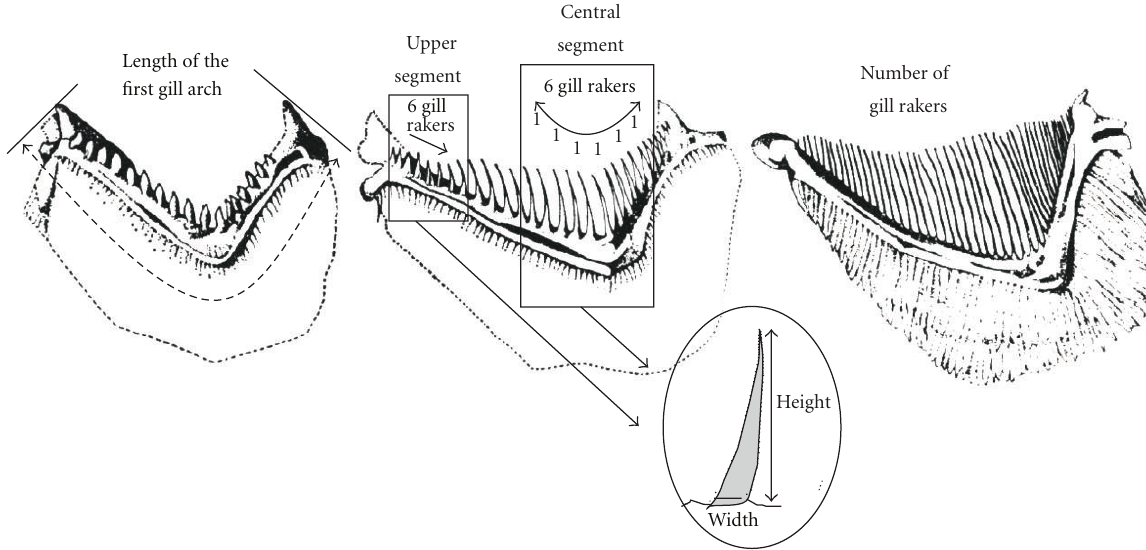
Figure 2: Diagram of variables measured on first gill arch for the analysis.